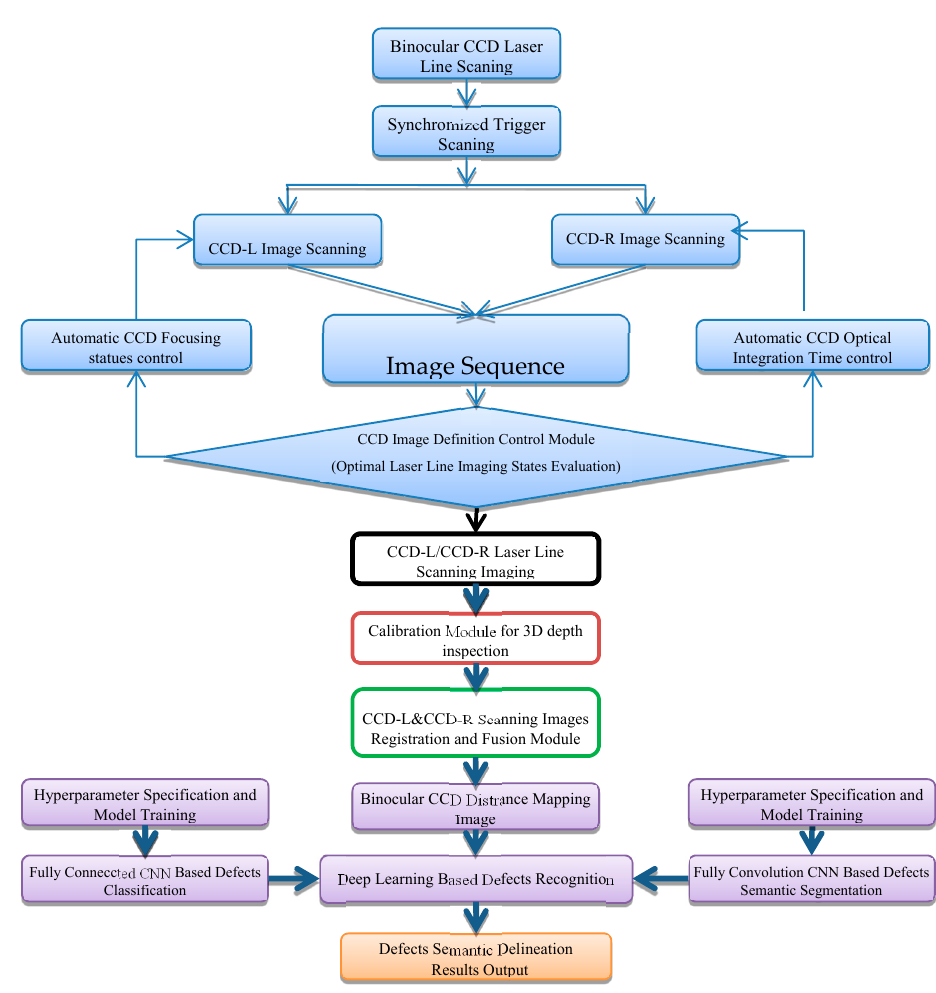
Figure 1. The scheme of binocular CCD-based 3D image deep-learning CC products surface defects inspection.